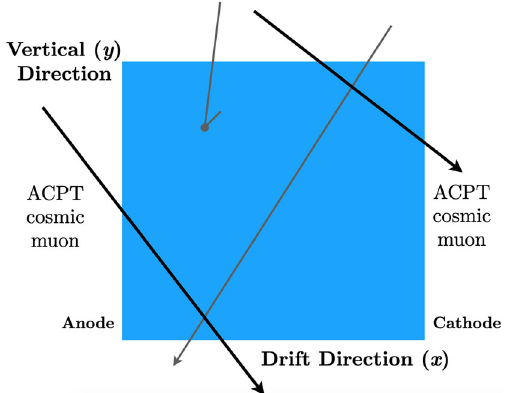
Fig. 3 Distribution of hit widths on the collection plane for 1 . 6 < x < 4 . 3 cm in the cosmic data. The spread in the distribution is driven by other sources of variability, such as the position in the yz -plane and the angular orientation of the track. The distribution is asymmetric and is not well described by any simple analytic function. This motivates the specialized algorithm based on the iterative truncated mean that is described in the text. A tick corresponds to 0.5 µ s of time